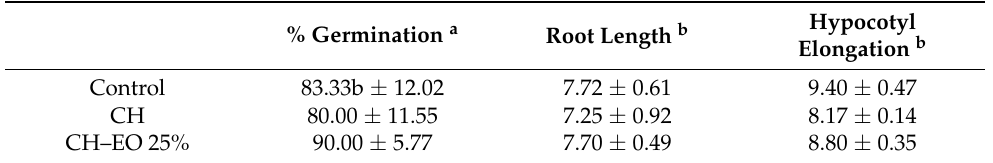
Table 5. Effects of CH and CH–EO of Ferulago campestris coating on seeds germination and radicle and shoot elongation of Phaseolus vulgaris